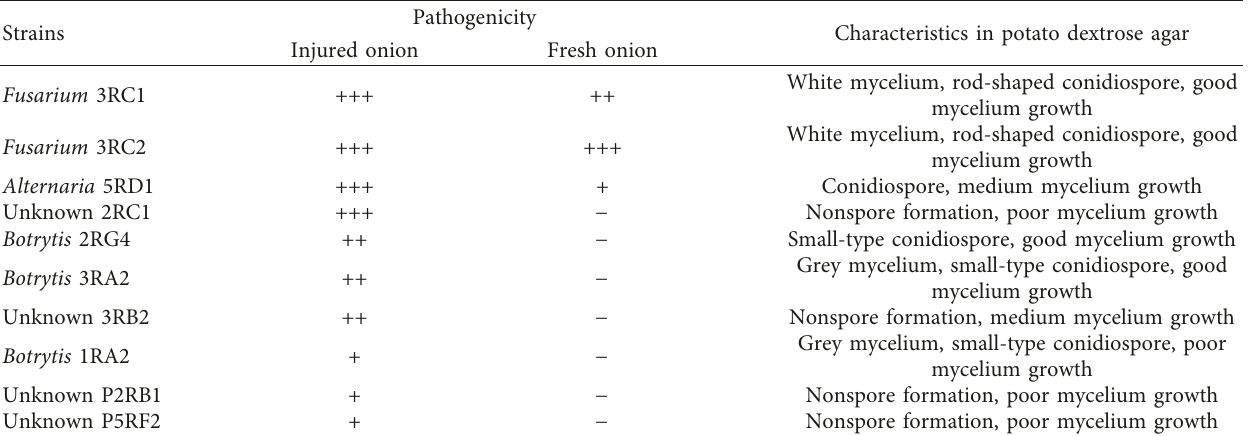
Table 3: Pathogenicity and characteristics of fungi isolated from decayed onions. Strains